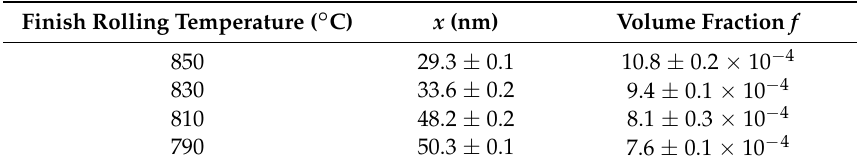
Figure 12. Percent distribution of precipitate particles of different size in the specimens varied with finish rolling temperature. Table 4. Average precipitate size and precipitation volume fraction of the specimens varied with finish rolling temperature.